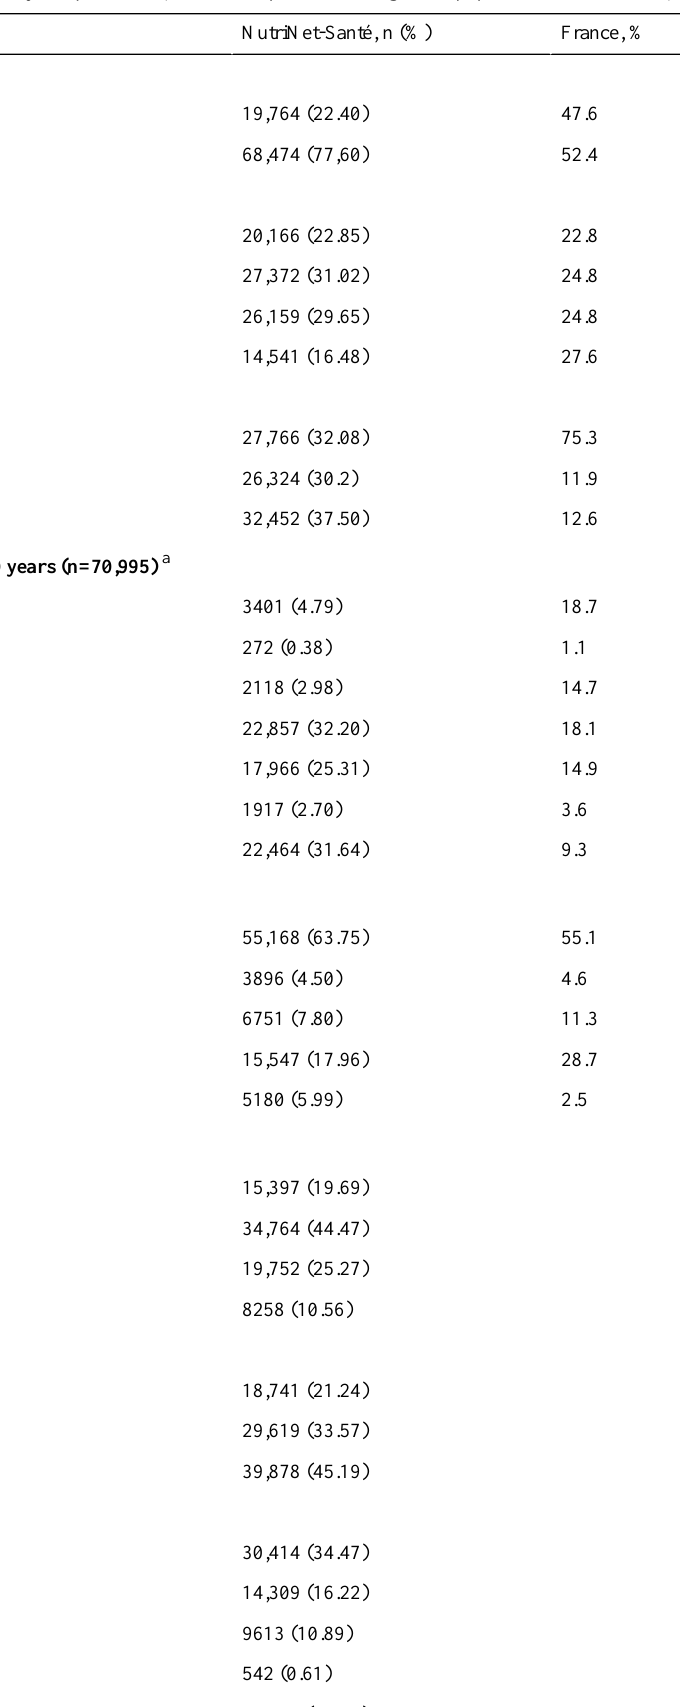
Table 1. Sociodemographic characteristics of the NutriNet-Santé Study sample (N=88,238) in comparison to the general population of France